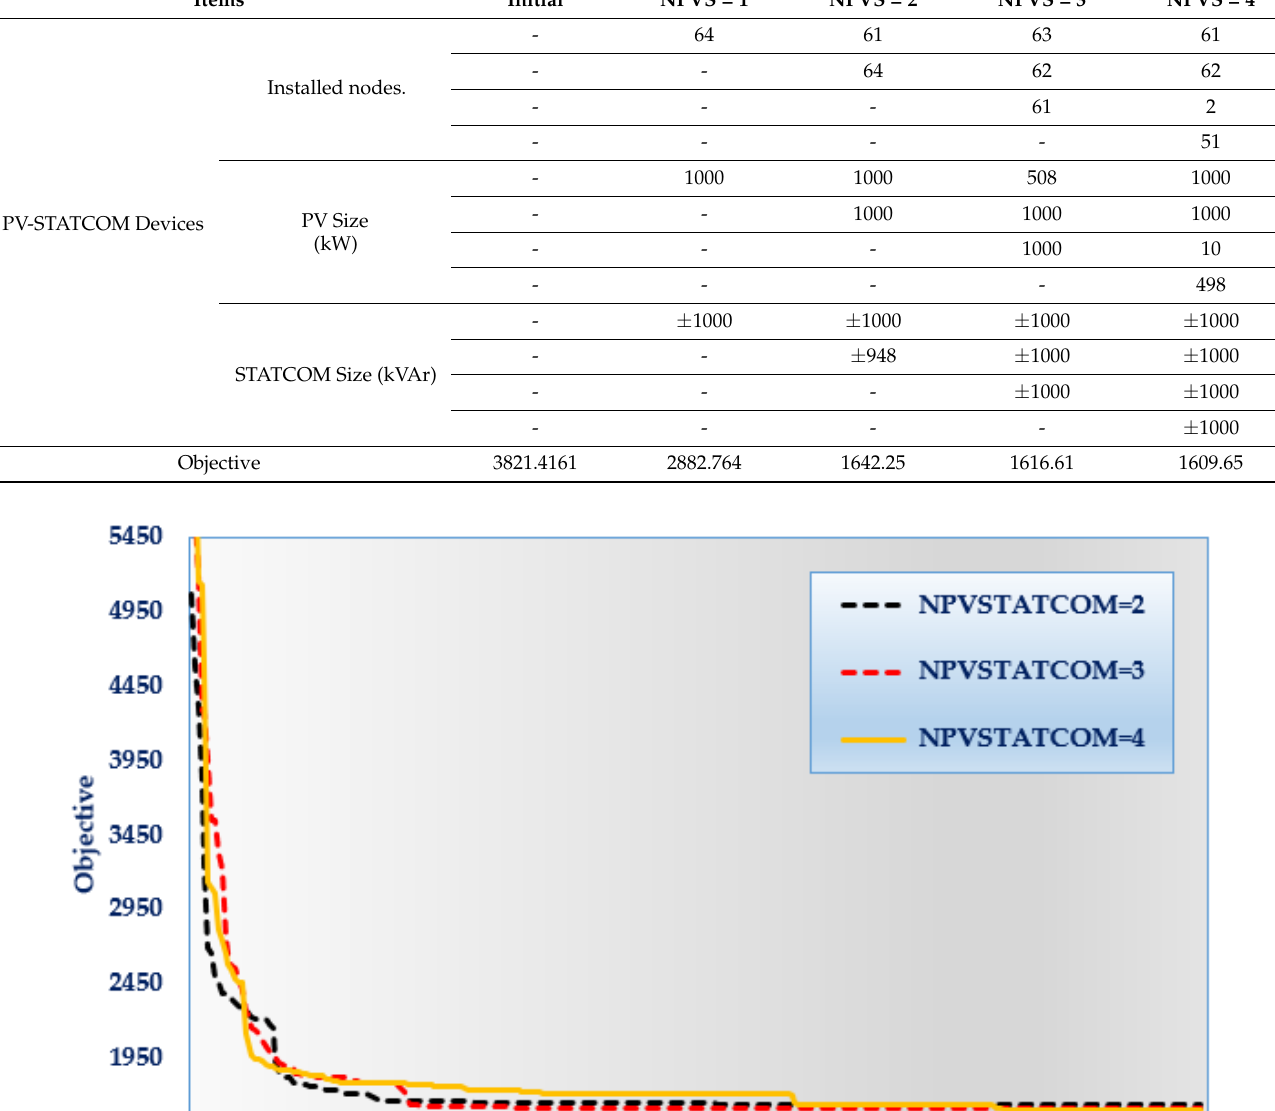
Table 4. PV-STATCOM allocations with varying the number of installed devices for IEEE 69- distribution feeder.